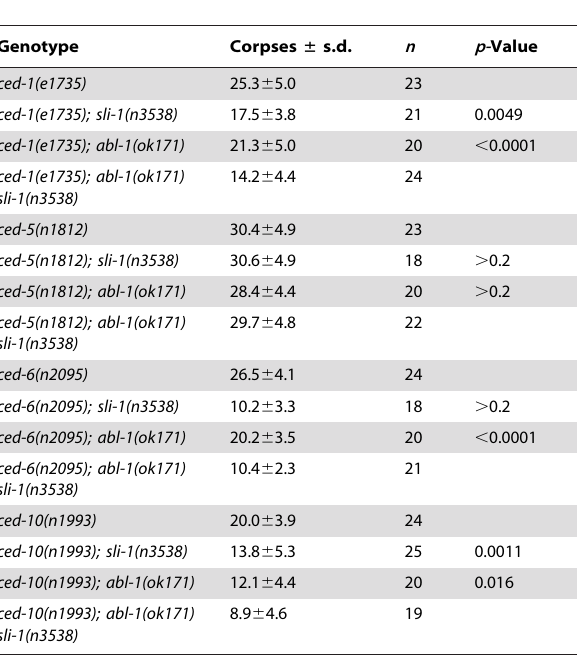
Table 3. Overexpression of sli-1 reverses the effect of sli- 1(sy143) on engulfment in ced-10(n1993); sli-1(sy143) animals.